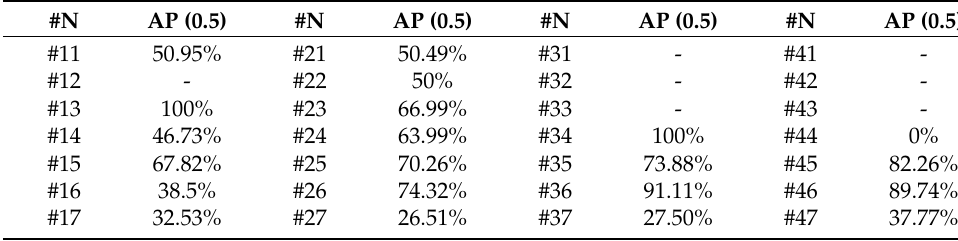
Table 4. Performance of missing teeth region detection model by tooth